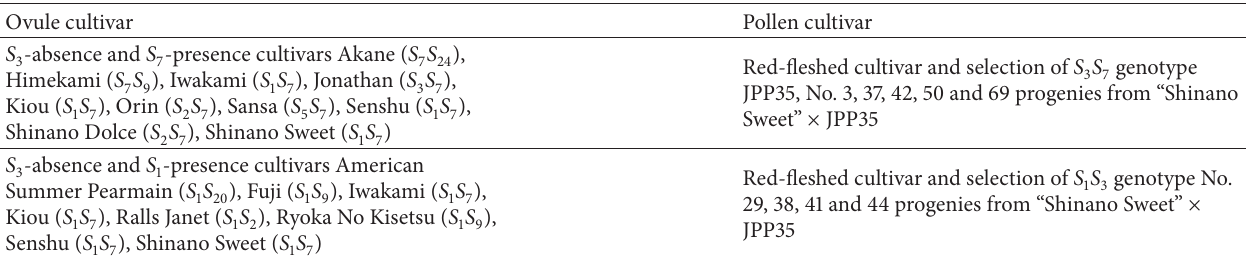
Figure 5: (a) A mature fruit of “Beniroman” produced at “Togokusan Fruit Park”. (b) Fruit development series of “Ruby Sweet” produced at NARO Institute of Fruit Tree Science (NIFTS). Scale bar 1 cm. Table 2: Cross-combination for efficient production of red-fleshed apple